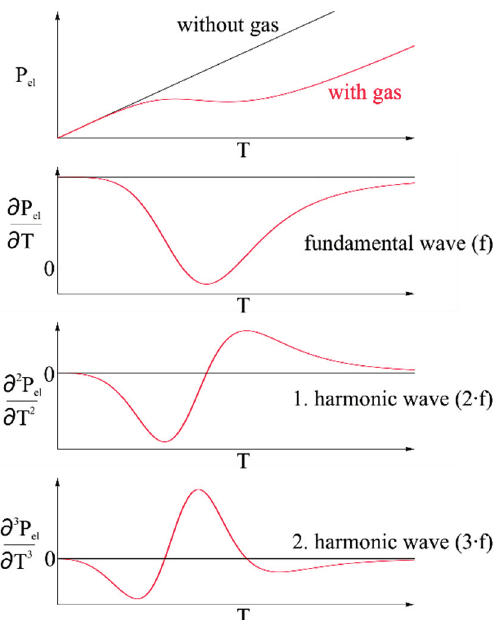
Figure 5. Harmonic waves of the electrical power as shown in Equation (6).